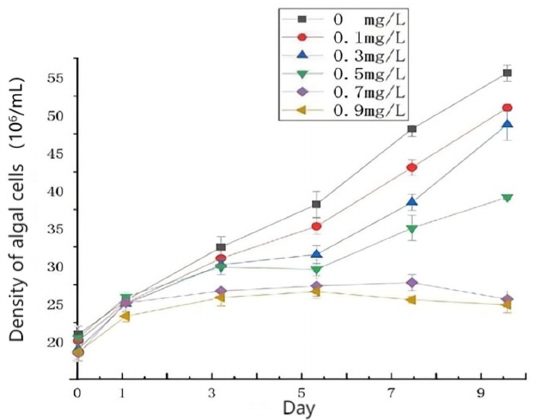
Figure 1. Effects of HgCl 2 concentration on the growth of Scenedesmus quadricauda .